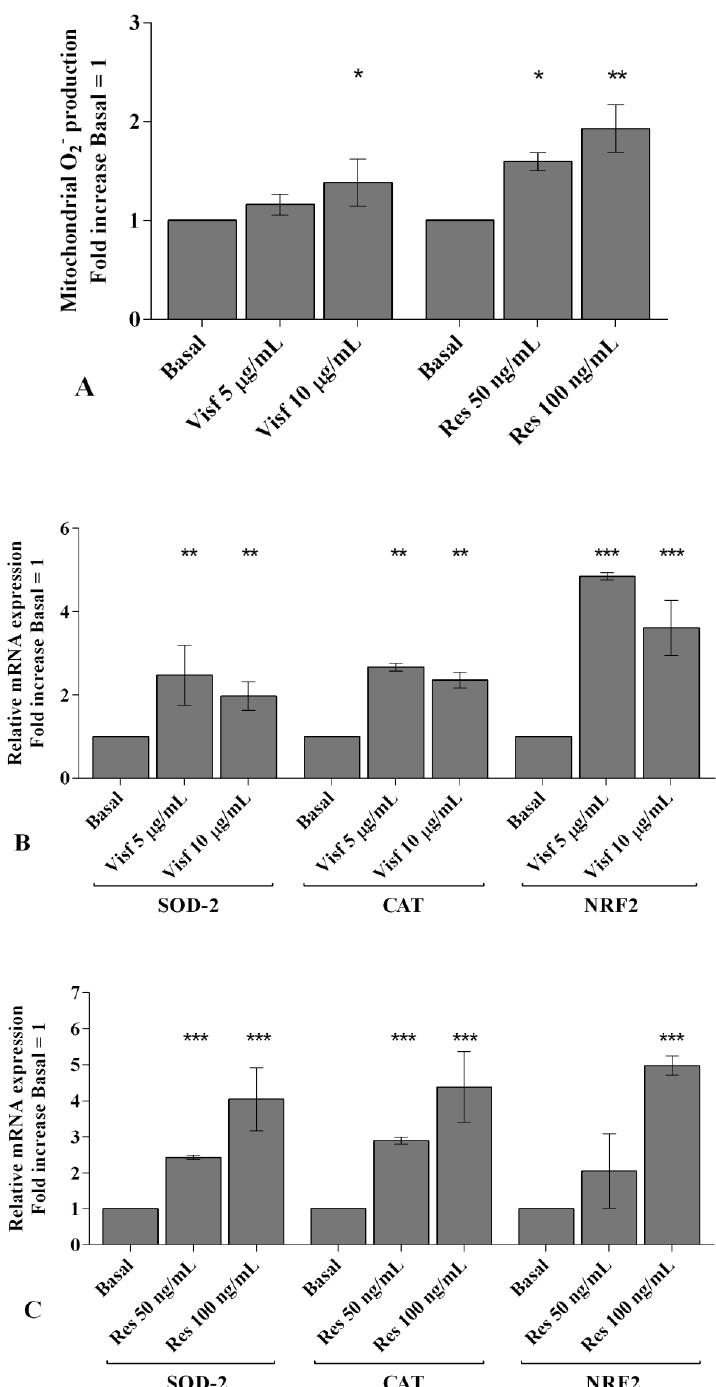
Figure 3. ( A ) Mitochondrial superoxide anion production was assessed by the analysis at flow cytometry using MitoSox Red staining. ( B , C ) Expression levels of superoxide dismutase ( SOD-2 ), catalase ( CAT ), nuclear factor erythroid 2 like 2 ( NRF2 ) by real-time PCR. Human osteoarthritic (OA) synovial fibroblasts were evaluated at basal condition and after incubation with visfatin (5 and 10 µ g / mL) and resistin (50 and 100 ng / mL) for 24 h. The superoxide anion production and the gene expression were referenced to the ratio of the value of interest and the value of basal condition (basal, cells without treatment), reported equal to 1. Data were expressed as mean ± SD of triplicate values. * p < 0.05, ** p < 0.01, *** p < 0.001 versus basal condition. Visf = visfatin, Res =